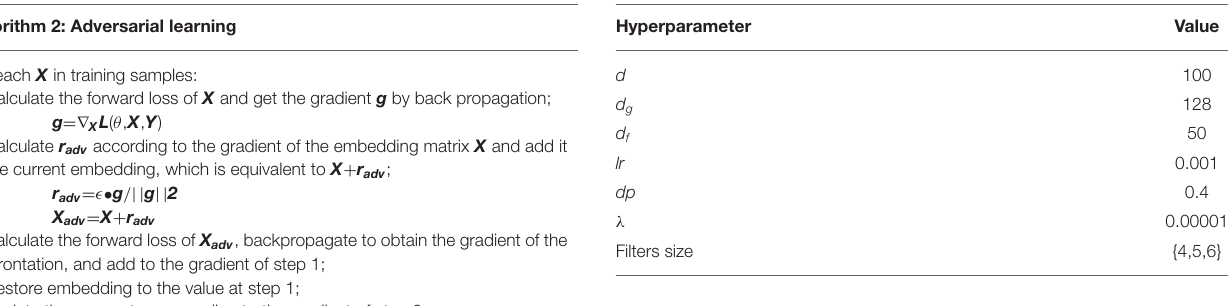
TABLE 4 | The hyperparameter settings of the